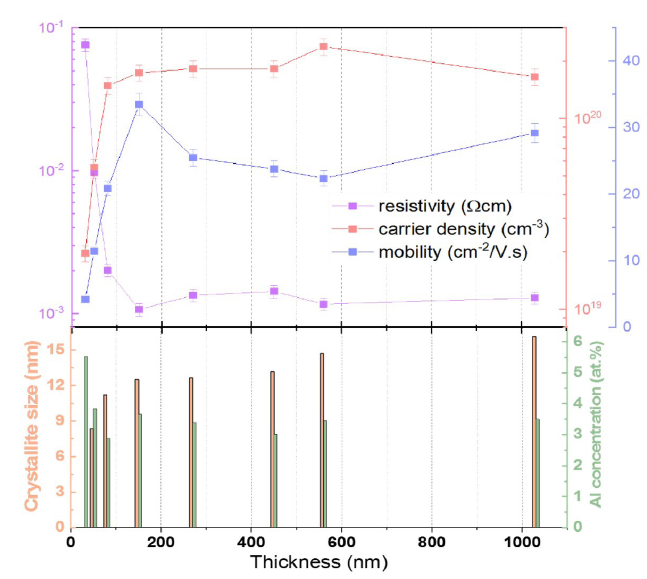
Figure 7. Electrical properties (top), crystallite size (bottom left), Al concentration (bottom right).